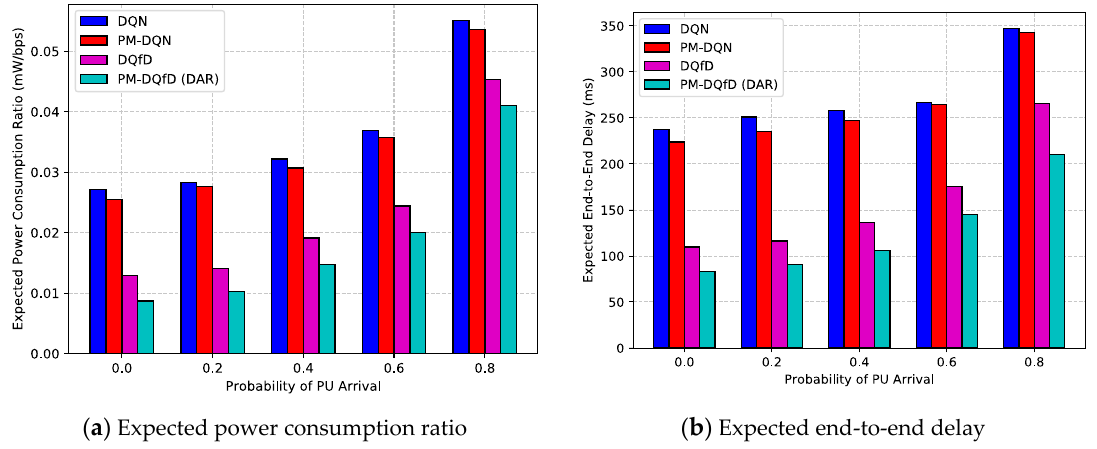
Figure 12 (a,b). Effectiveness properties versus probability of PU arrival. Figure 12. ( a , b ) E ff ectiveness properties versus probability of PU